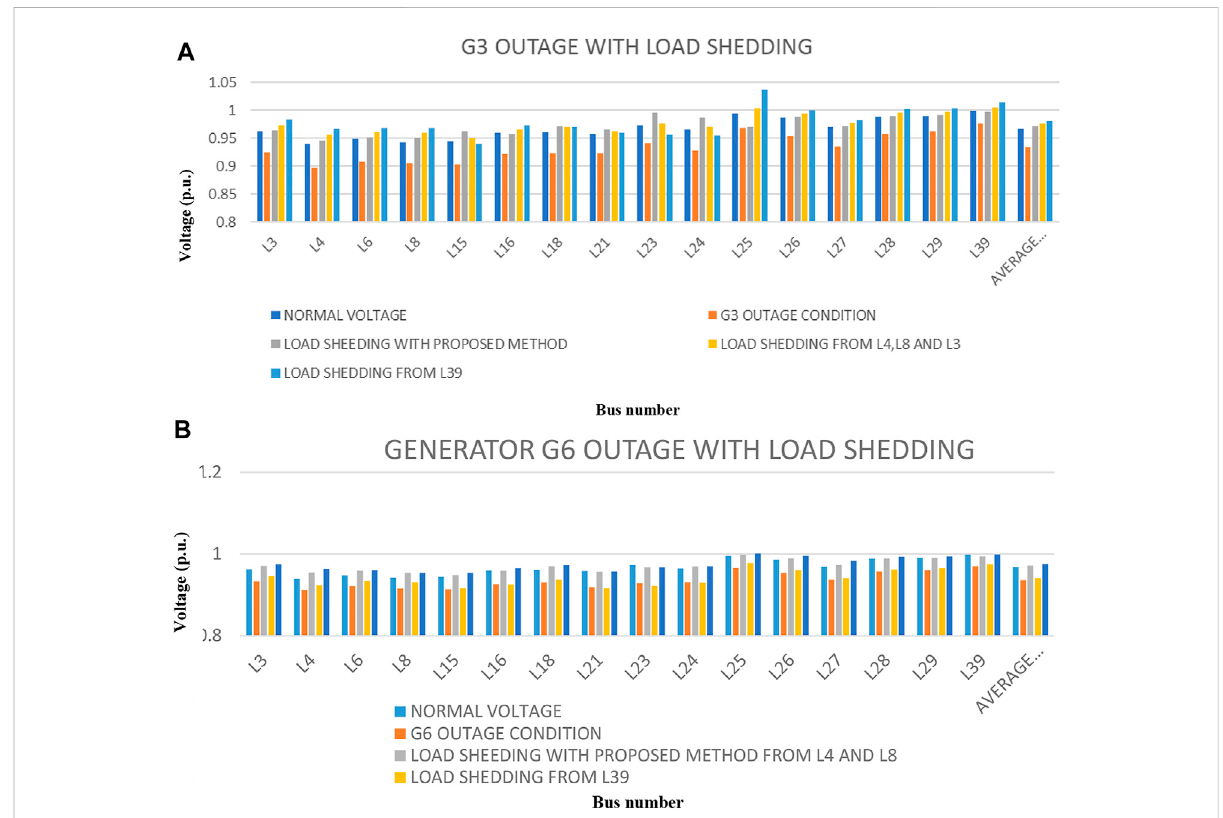
FIGURE 2 (A) Voltagepro fi leofloadterminalincaseofgeneratorG 3 outagewithdifferentmannersofloadshedding. (B) Voltagepro fi leofloadterminalin case of generator G 6 outage with different manners of load